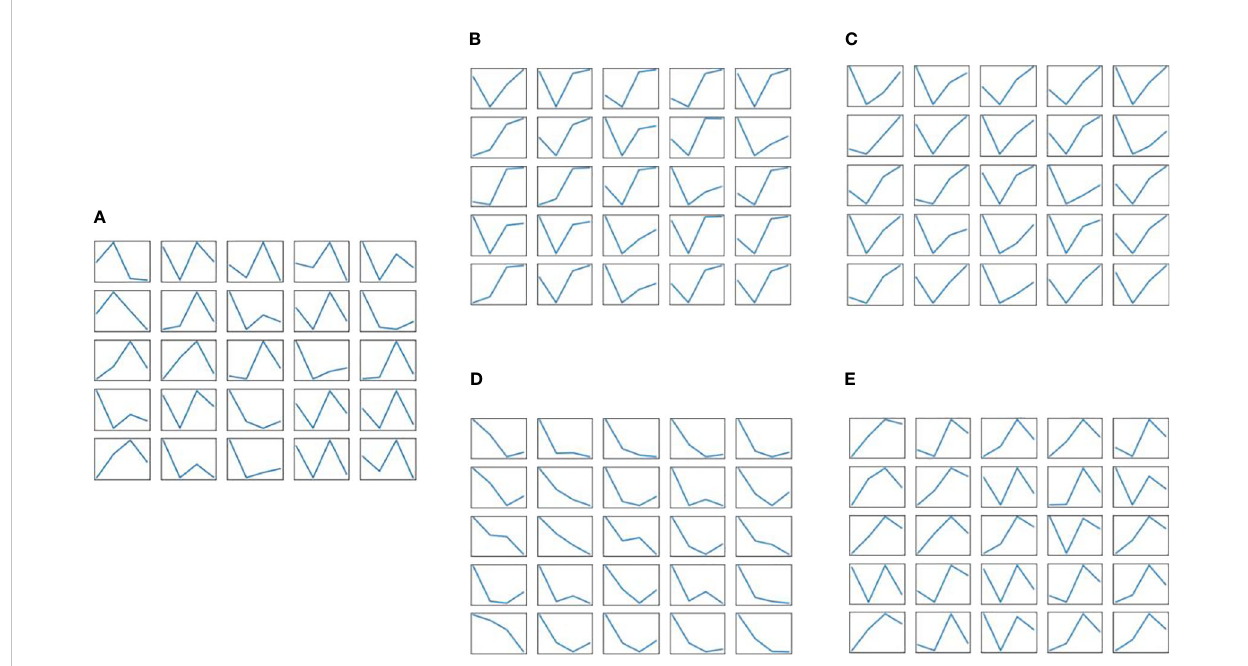
FIGURE 4 The real sample data and the generated sample data are randomly sampled, and the generated sample data are saved every 50 epochs. (A) Real sample data. (B) Generated sample data when e=50. (C) Generated sample data when e=1000. (D) Generated sample data when e=2850. (E) Generated sample data when